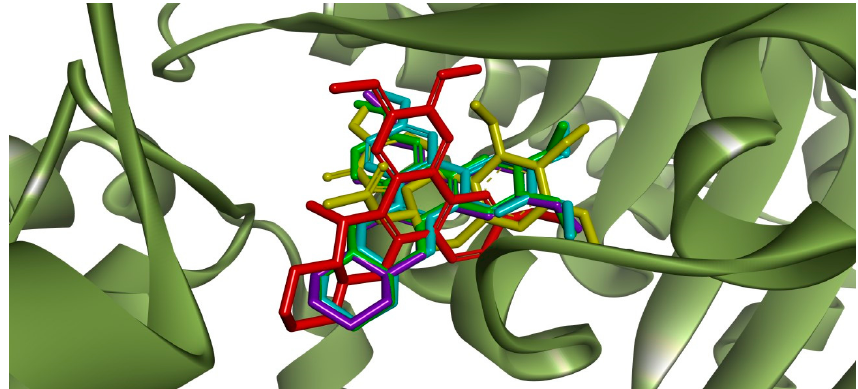
Figure 3. Superposition between the crystallographic pose of colchicine (yellow) at the corresponding binding site in the β -tubulin monomer (PDB ID: 4O2B) [8] and the docking poses of the alkaloids R -boehmeriasin A (green), R -boehmeriasin B (purple), R -cryptopleurine (light blue) and ( − )-C (15 R )-hydroxycryptopleurine (red).